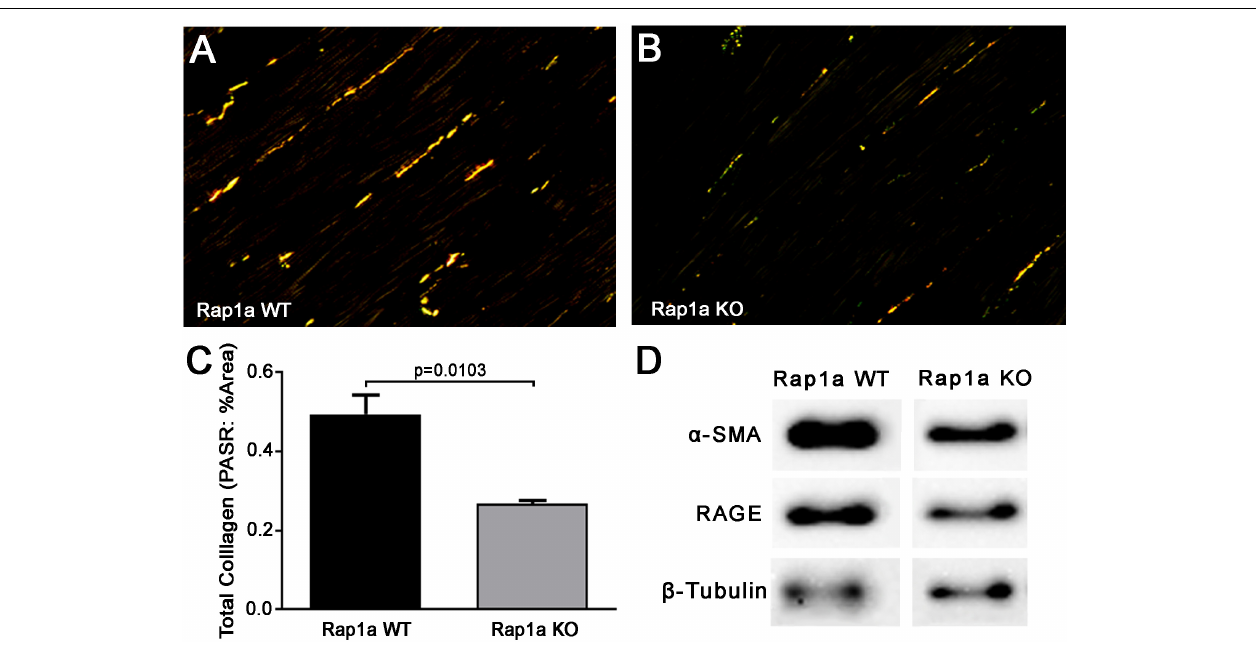
FIGURE 2 | Knockout of Rap1a resulted in decreased collgen expression in hearts ( in vivo ) and reduced protein expression of specific AGE/RAGE signaling markers in cardiac fibroblasts ( in vitro ). Hearts from Rap1a wild-type (WT; A ) and knockout (KO; B ) mice were sectioned and stained with picric acid sirius red (PASR) which fluorescences with exposure to polaized light. Total collagen was determined by normalizing the amount of PASR fluorescence to the percent area and graphed as mean ± SEM (C) . Student’s t -test was preformed to assess significance with a sample size of three to four hearts. Protein expression for specific AGE/RAGE signaling cascade indicators was assessed in cardiac fibroblasts isolated from Rap1a WT and KO hearts (D) . Alpha smooth muscle actin ( α -SMA) was used to indicate the presence of differentiated fibroblasts (myofibroblasts) and RAGE indicated expression of the receptor for AGE (RAGE). β -Tubulin was used as a loading control. Western blot images shown are not displayed as a continuous blot due to running on different membranes.